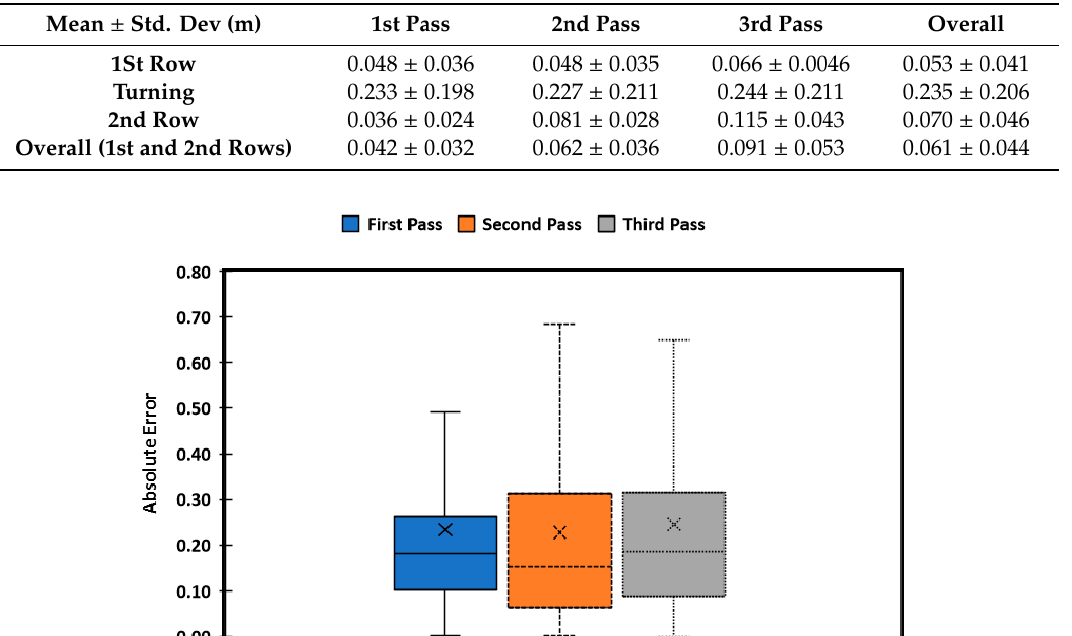
Figure 16. The average of absolute errors (A.E.) in the first, second, and third non-turning passes (blue, orange, and gray boxes, respectively). The boxes present the first quartile to the third quartile of A.E., while the whiskers show maximum values and minimum values of each of the passes. The “x” shows the mean absolute error (MAE) for each of the passes. Table 1. The mean absolute error and standard deviations of the three passes along the cotton rows.